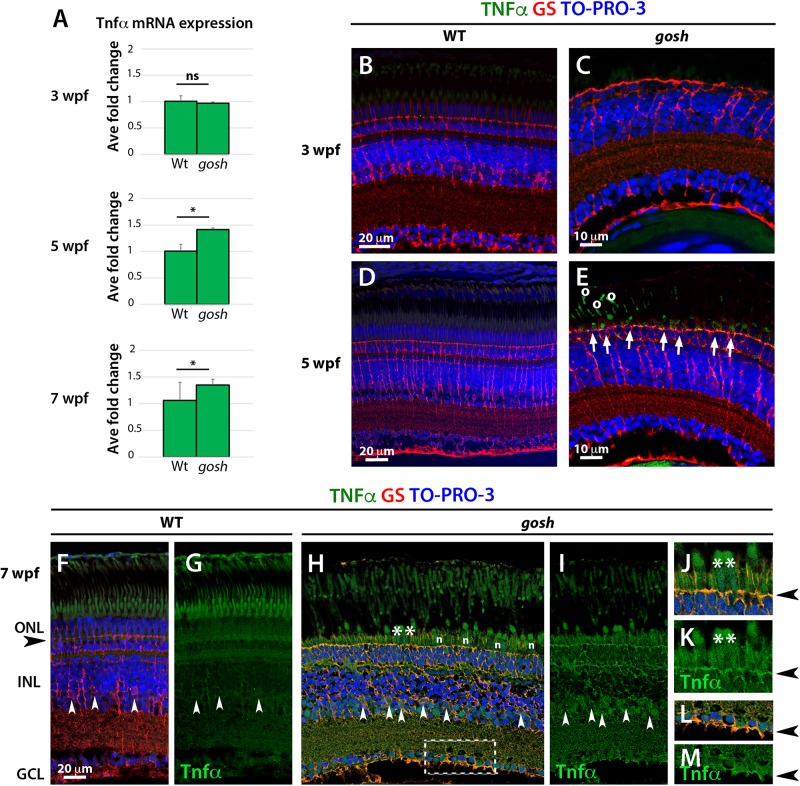
TNFα is detected in cones at 5 wpf and in Müller glia at 7 wpf in gosh mutants. (A) Quantitative PCR histogram of 3, 5, and 7 wpf of control and gosh samples. 3 wpf of control and gosh samples displayed similar levels of TNFα mRNA. Upregulation of TNFα mRNA at 5 and 7 wpf in gosh samples relative to control samples. (B–M) Paraffin sections of wild-type sibling and gosh mutant retinas were labeled with antibodies against TNFα and GS at 3, 5, and 7 wpf. Müller glia are visualized as cells with nuclei located in the INL and radial processes that span the apico-basal axis of the neural retina. Wild-type sibling retinas exhibit undetectable levels of TNFα (B,D). gosh mutant retinas show no TNFα immunoreactivity at 3 wpf, as in wild-type retinas (C); however, degenerating cones display labeling against TNFα at 5 wpf (E, arrows). Circles in (E) denote autofluorescence. Nuclei of Müller glia are localized in the INL (white arrowhead) and their basal and apical processes reach the basal region of the retinal ganglion cell layer and the outer limiting membrane (black arrowhead) in the ONL in 7-wpf wild-type retinas (F,G). TNFα immunoreactivity is absent, although background signals are observed in the cone outer segment. However, in gosh mutant retina, strong signals are detected in dying cones (H, asterisks) and weaker signal in Müller glia (white arrowhead) and their cell process (H,I). (J,K) indicate high magnification images of the ONL shown in (H, asteriks). (L,M) indicate high magnification images of basal foot shown in (H, dotted box). The outer limiting membrane (J,K, black arrowhead) and the basal feet of Müller glia (L,M) are strongly stained. Amacrine and ganglion cells show faint TNFα-positive signal (H,I). n: nuclei of cone photoreceptors (ns, p > 0.05; ∗p < 0.05).